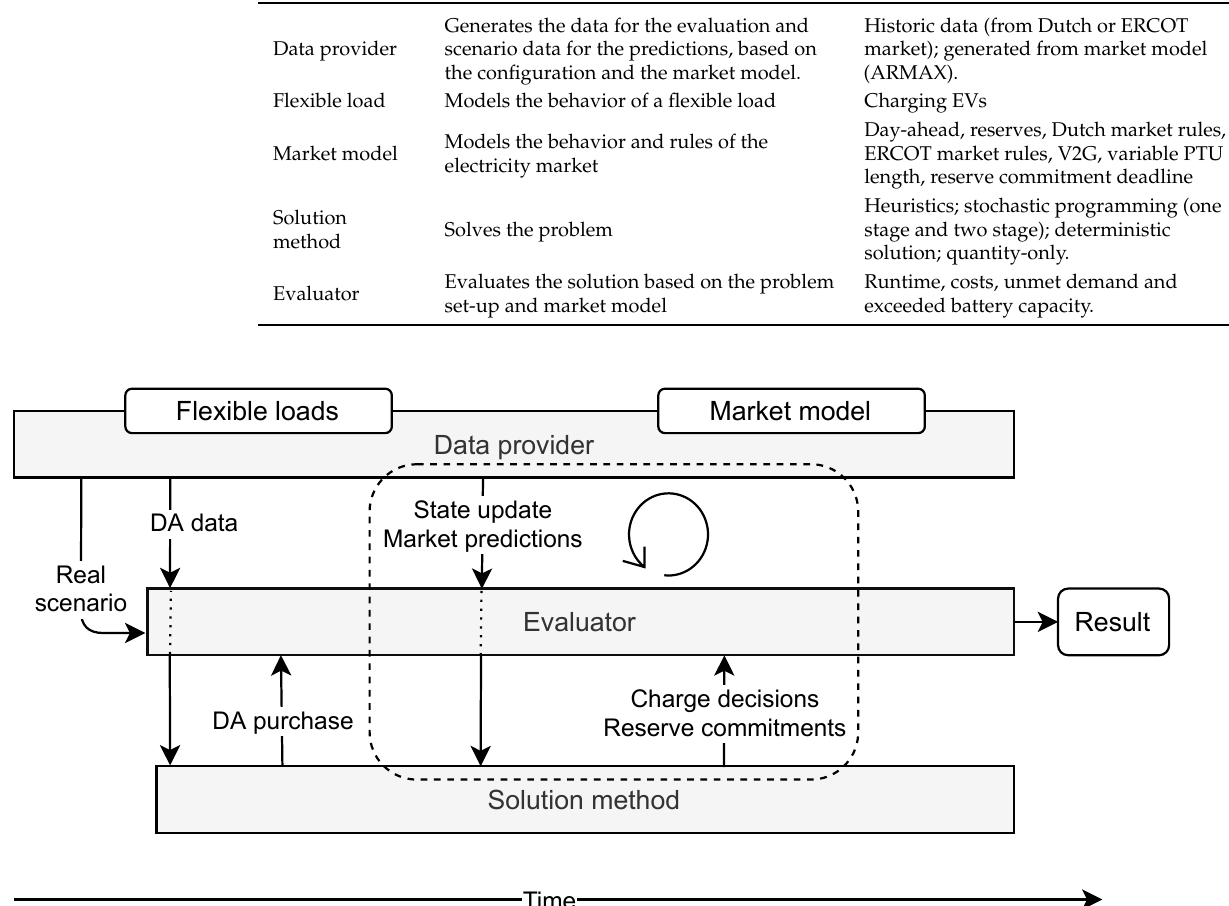
Figure 1. The interactive flow between the simulation and the solution method. The data provider generates a real scenario, which is then used in the simulation. The solution method makes day-ahead (DA) purchases based on DA price data. The simulation then proceeds step by step through every time step, providing the solution method with updated information from the data provider and receiving new decisions from the solution